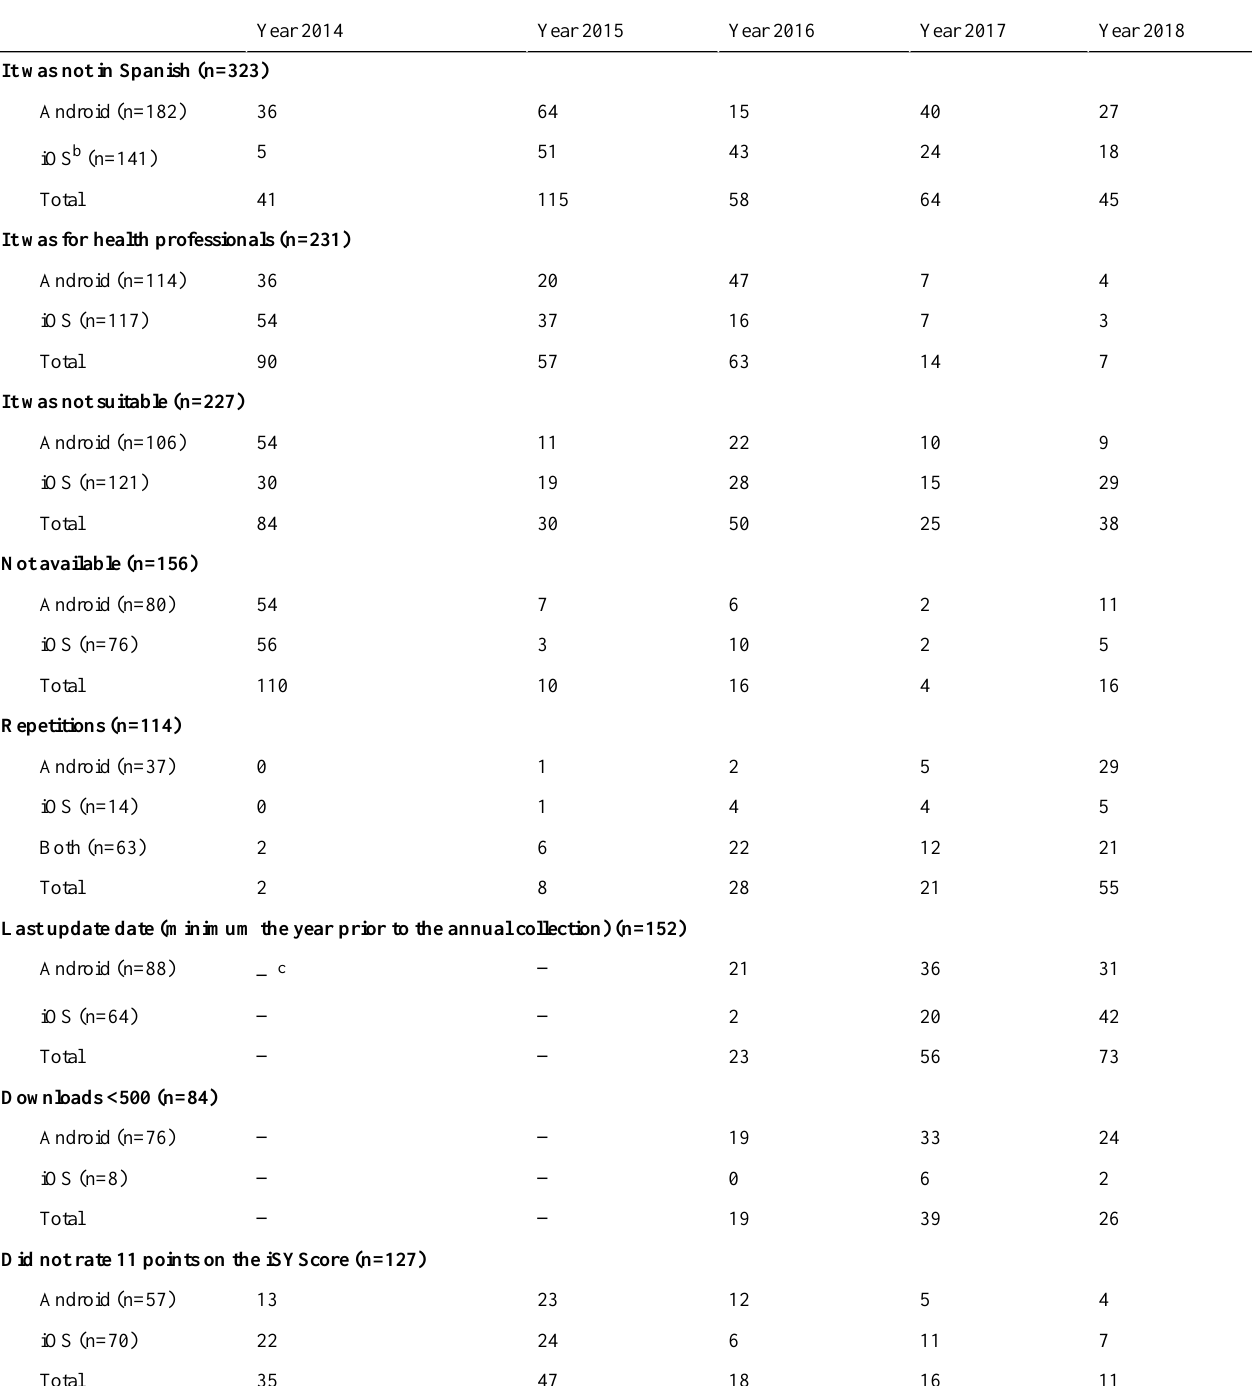
Number of apps in each yearReasons, operating